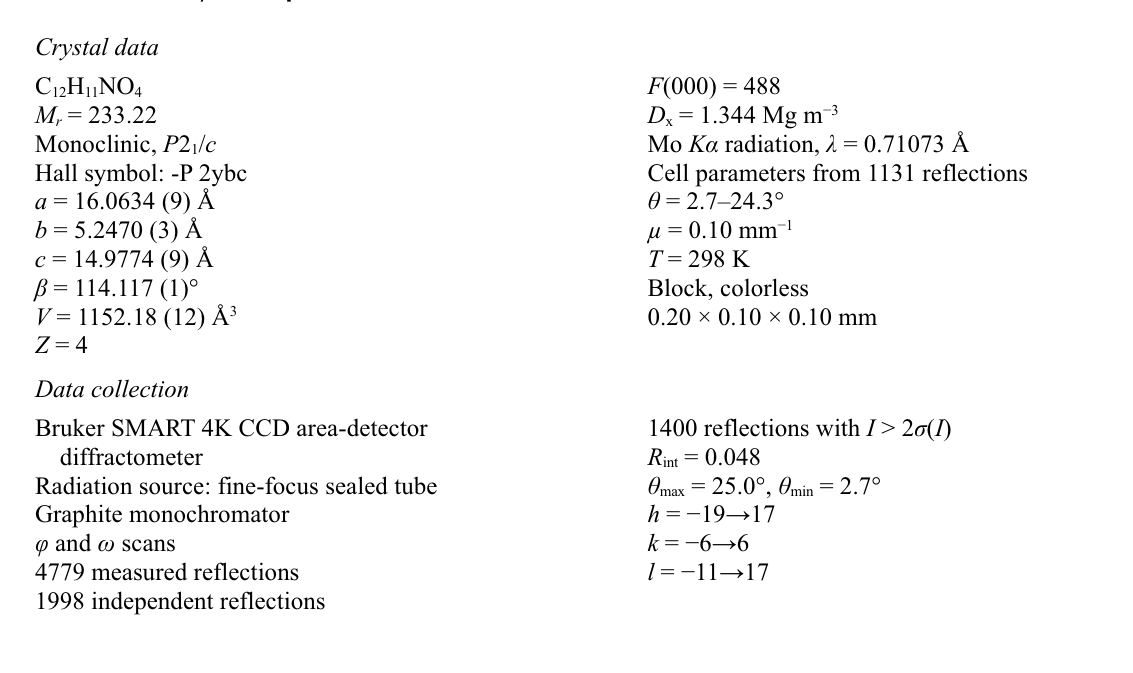
View of the title molecule, showing the atom-labelling scheme. The displacement ellipsoids are drawn at the 30% probability